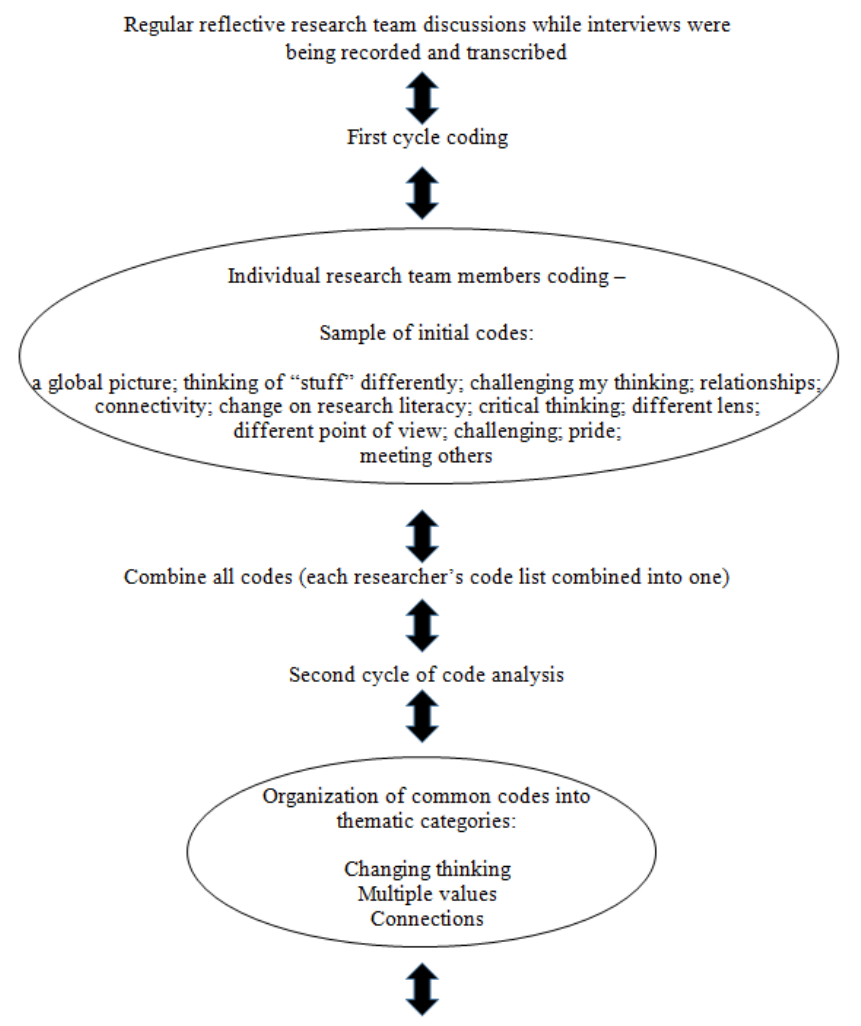
Figure 1. The data analysis process indicating the sequence of actions taken during the reduction of